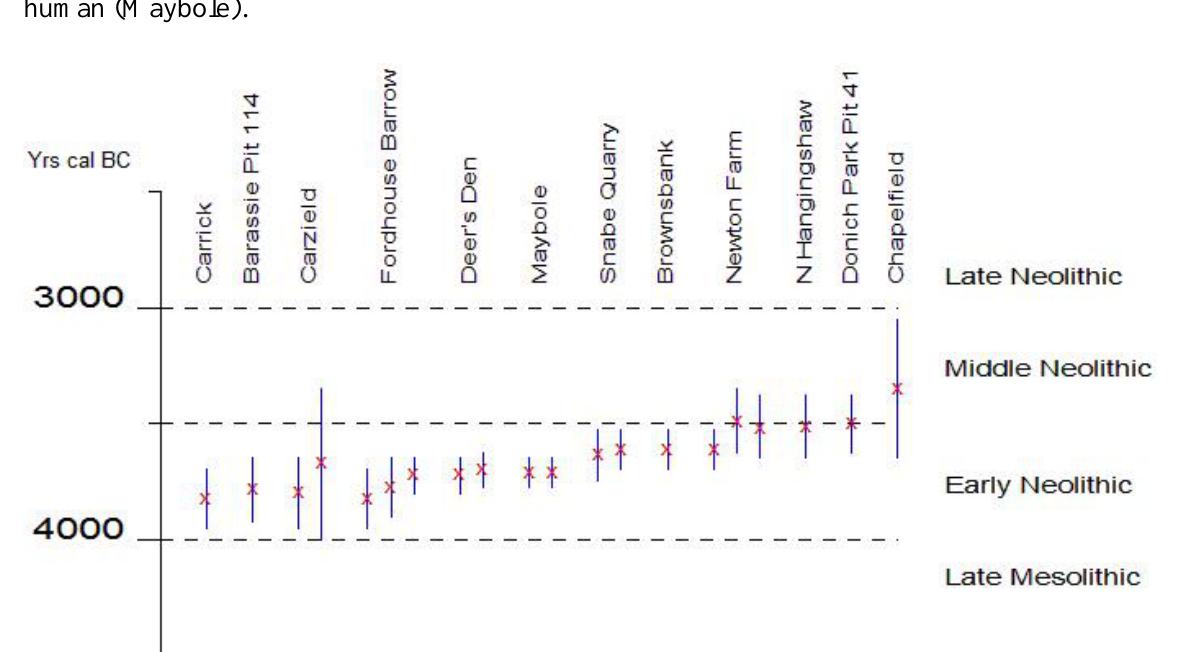
Figure 3. Radiocarbon dates relating to pitchstone-bearing pits (site names along the top of the diagram). Note that the dates from Fordhouse Barrow are TAQ dates provided by charcoal recovered immediately above the pitchstone-bearing pit; a leaf-shaped point from this pit defines the deposition as EN, and the pitchstone from the Fordhouse Barrow pit therefore clearly dates to the first half of the Early